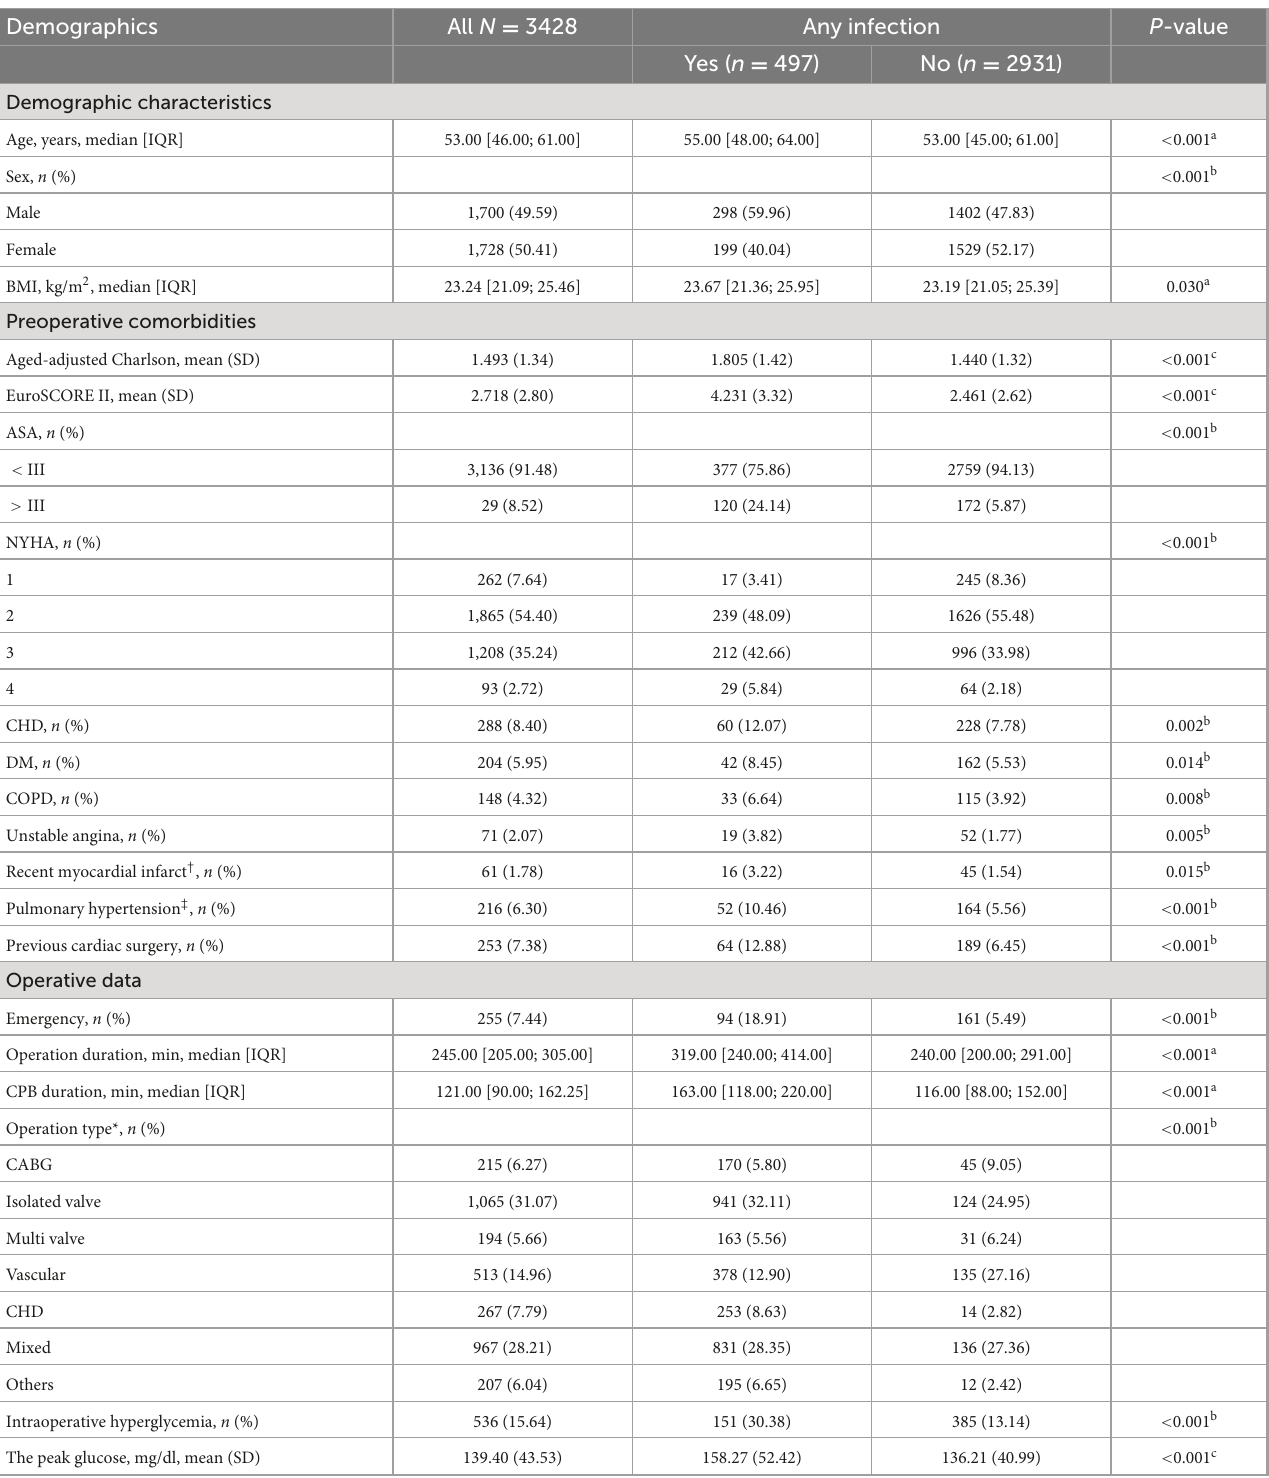
TABLE 1 Demographics and clinical characteristics stratified by composite primary